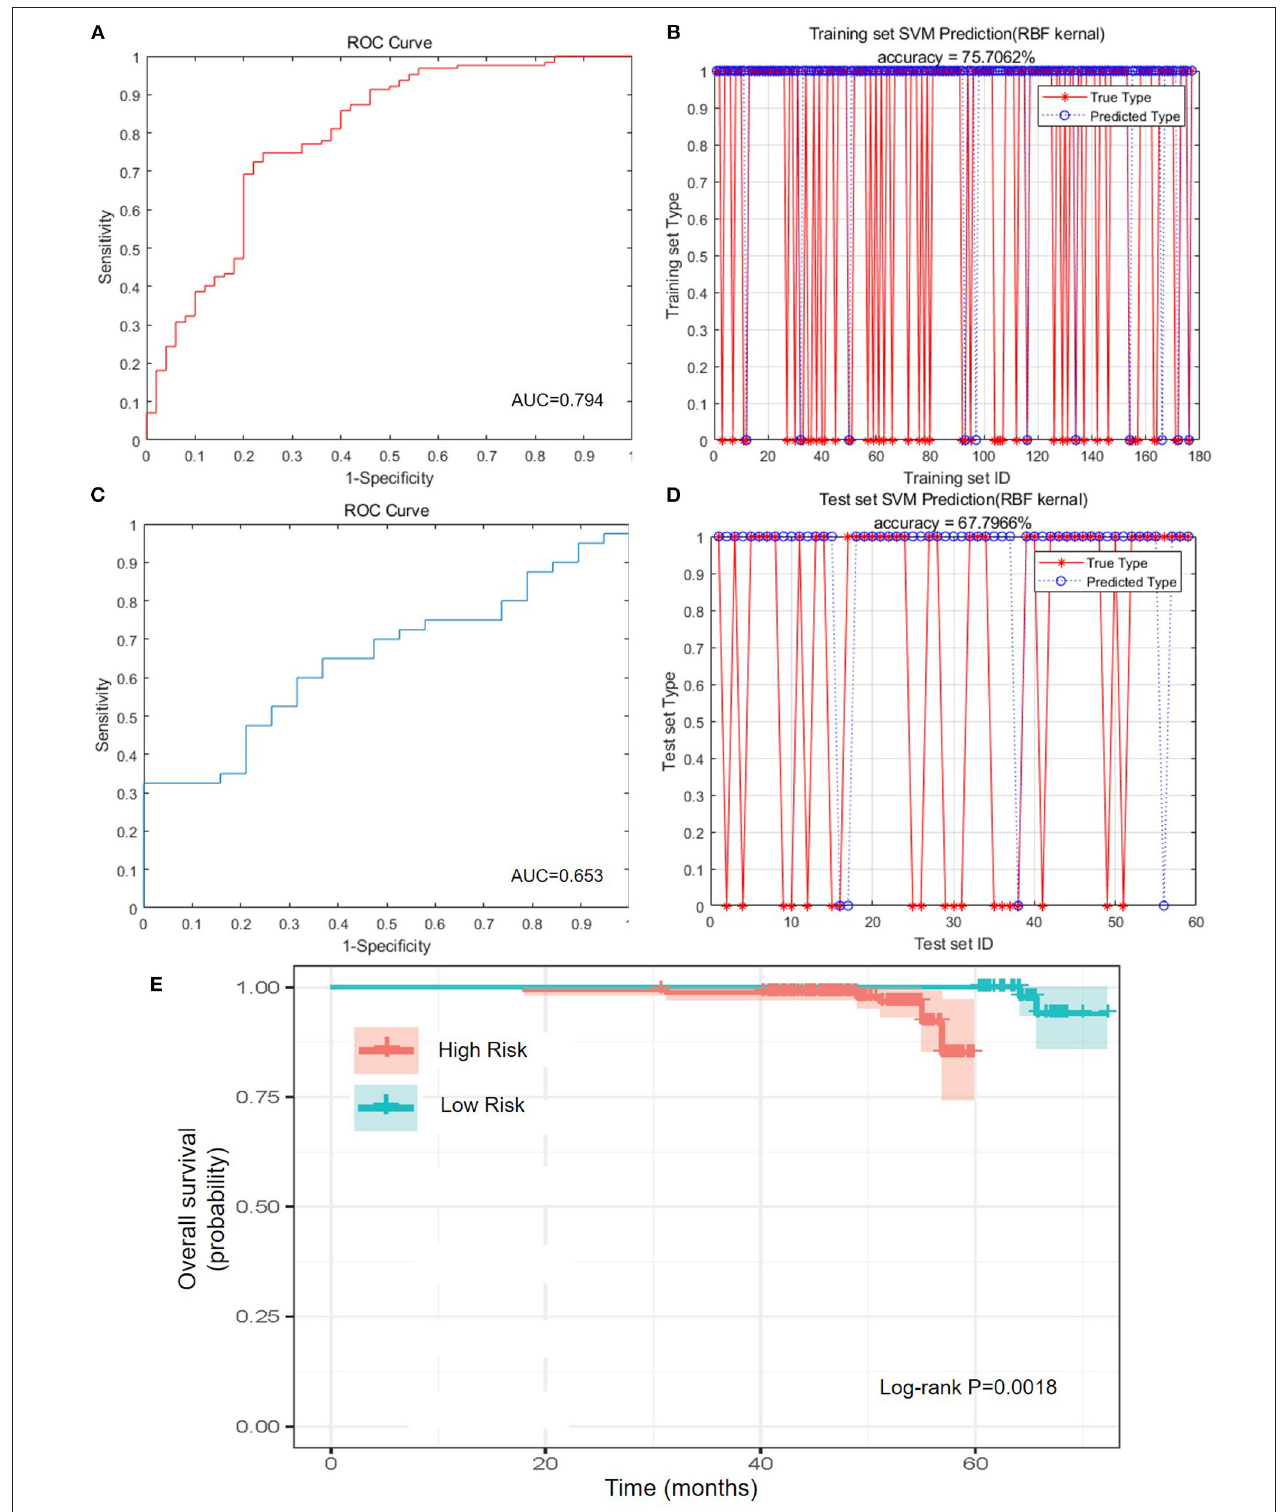
FIGURE 3 | Predictive efficacy of NATIM. (A) Receiver operating characteristic (ROC) curve and area under curve (AUC) of NeoAdjuvant Therapy Immune Model (NATIM) in training cohort. (B) Prediction accuracy of NATIM in training cohort. (C) ROC and AUC of NATIM in test cohort. (D) Prediction accuracy of NATIM in test cohort. (E) Kaplan–Meier plot of NATIM between high- and low-risk population.